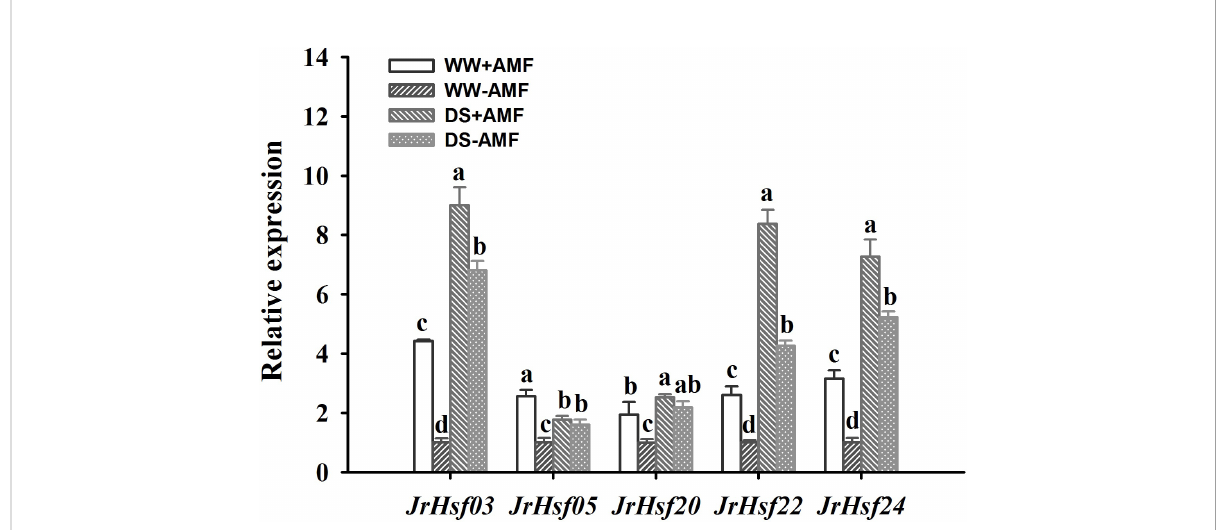
FIGURE 5 Effect of AMF ( Diversispora spurca ) on Hsfs gene expression levels in leaves of walnut under well-watered (WW) and drought stress (DS). Data (means ± SD, n = 3) are signi fi cantly different ( P < 0.05), if followed by different letters above the